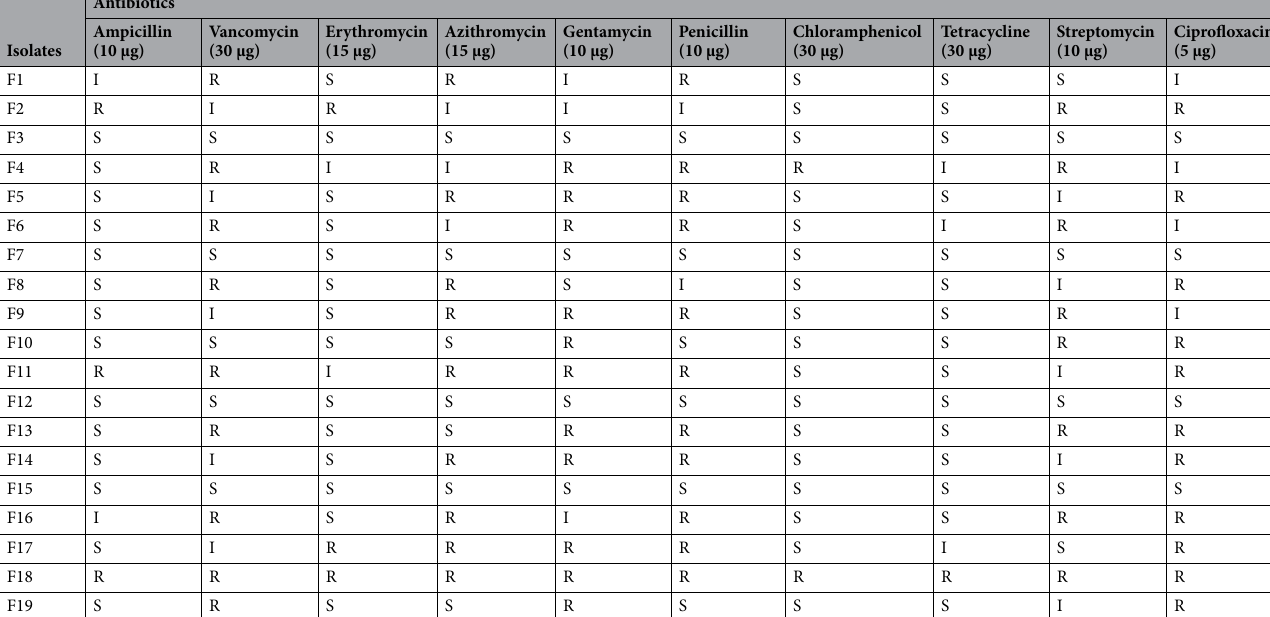
Table 2. Antibiotic susceptibility profile of isolates. I: intermediate susceptibility (zone diameter 12.5– 17.4 mm); R: resistant (zone diameter < 12.4 mm); S: susceptible (zone diameter >